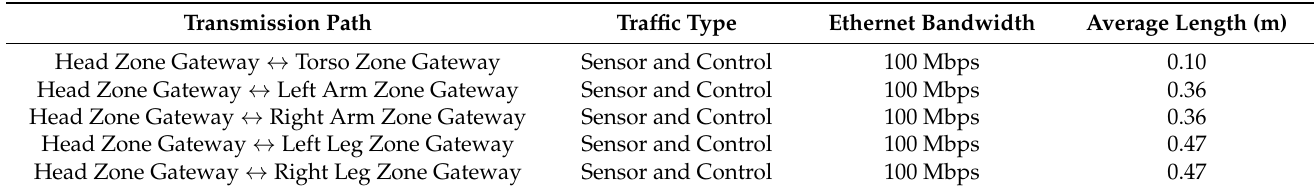
Table 11. Data transmission link parameters of the link connecting the Head Zone Gateway and each Zone Gateways.